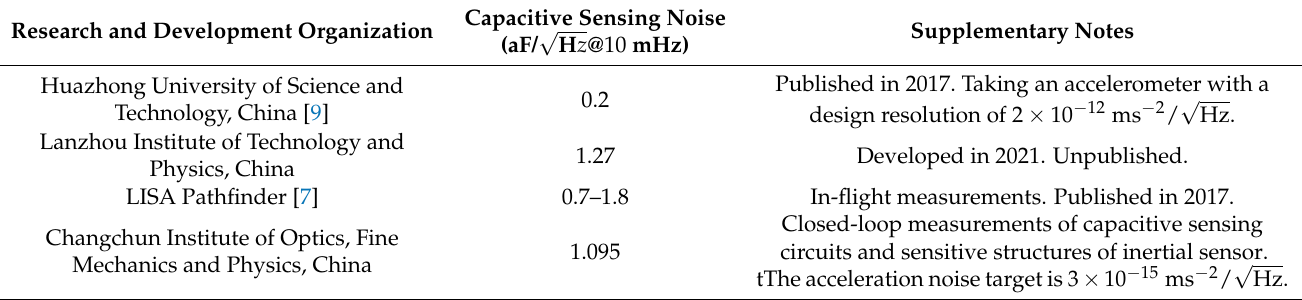
Table 5. Comparison of capacitive sensing noise